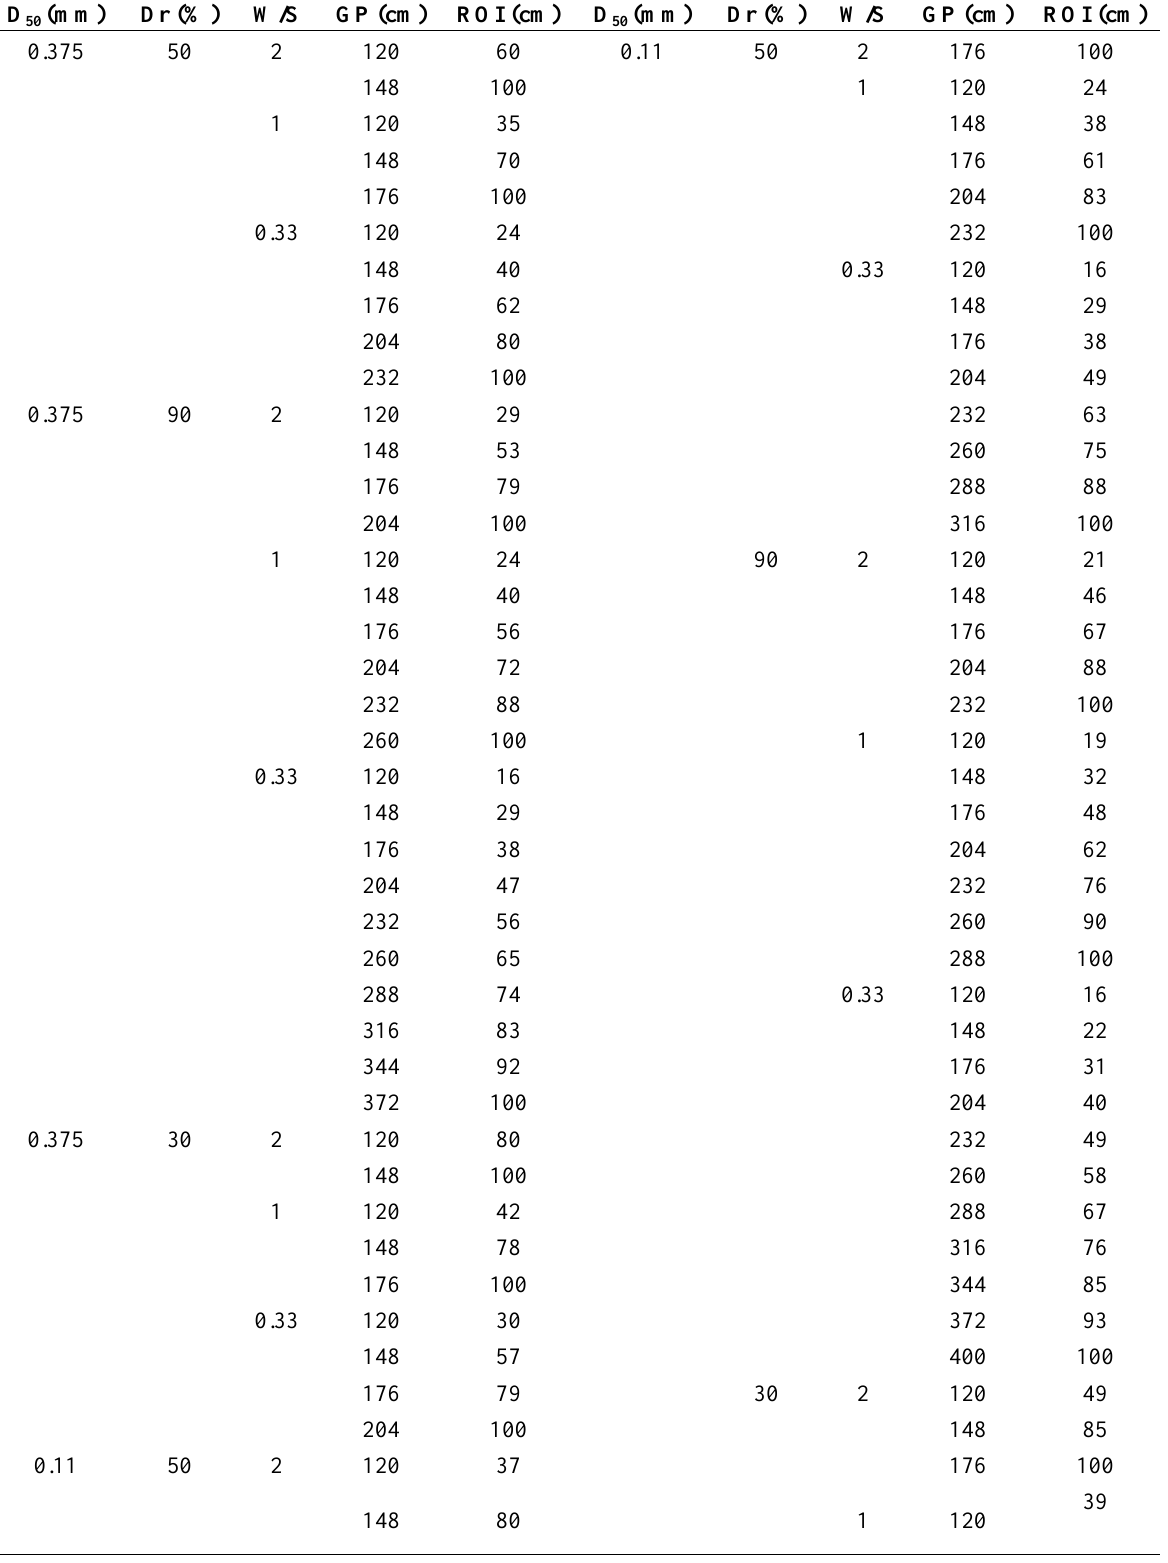
Table 1. Experimental